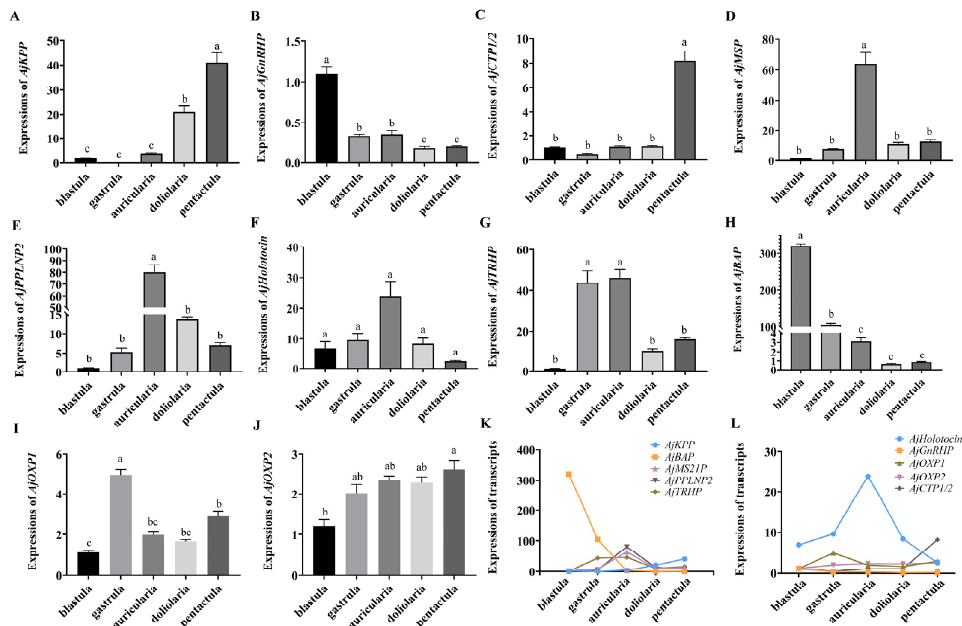
Figure 5. Relative transcriptional level of NP genes in the embryos and larvae of the sea cucumber A. japonicus revealed by quantitative real-time PCR (qRT-PCR). ( A ) AjKPP ; ( B ) AjGnRHP ; ( C